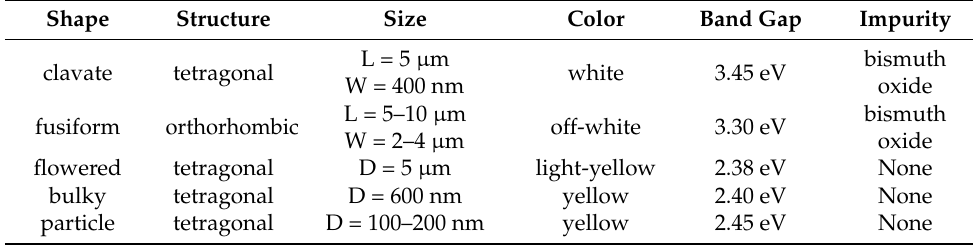
Figure 2. ( A ) XRD patterns, ( B ) UV – Vis spectra, ( C ) Kubelka – Munk plots of BiVO 4 . Inset of ( B ) is the photographs of clavate, fusiform, flowered, bulky, and particle from 1 to 5. High-resolution XPS spectra of ( D ) V 2p, ( E ) Bi 4f, and ( F ) O 1s of different morphologies BiVO 4 . Table 1. Properties of BiVO 4 samples with different morphologies.